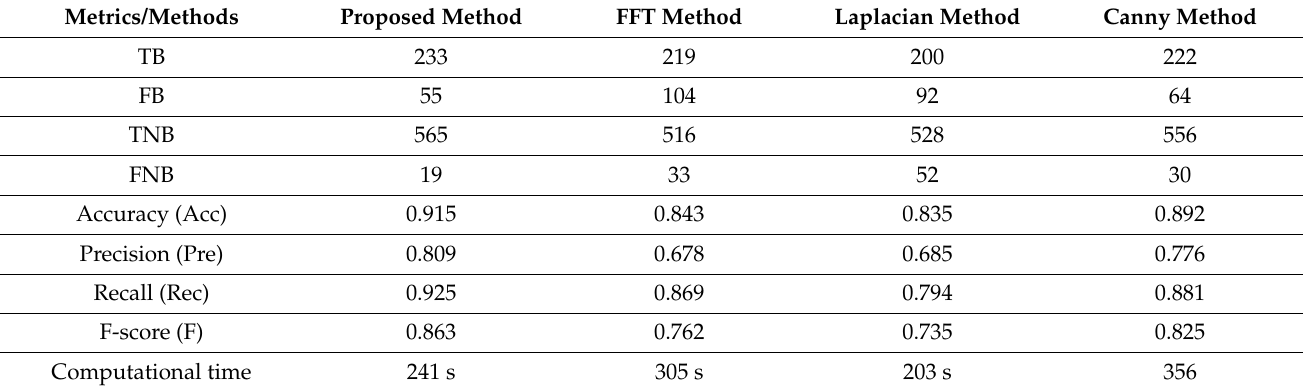
Table 1. Comparative analysis of different blur-detection